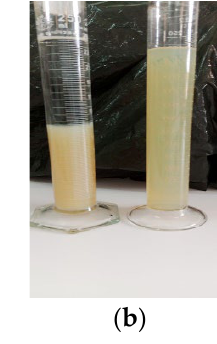
Figure 1. ( a ): Jar test apparatus used in this study; ( b ): treated water.